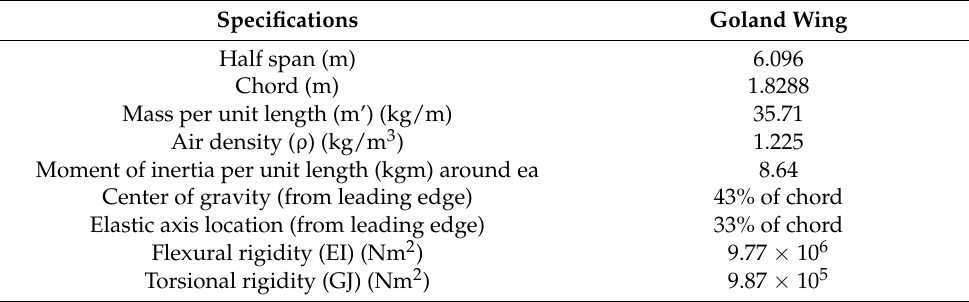
Table 1. Properties of Goland